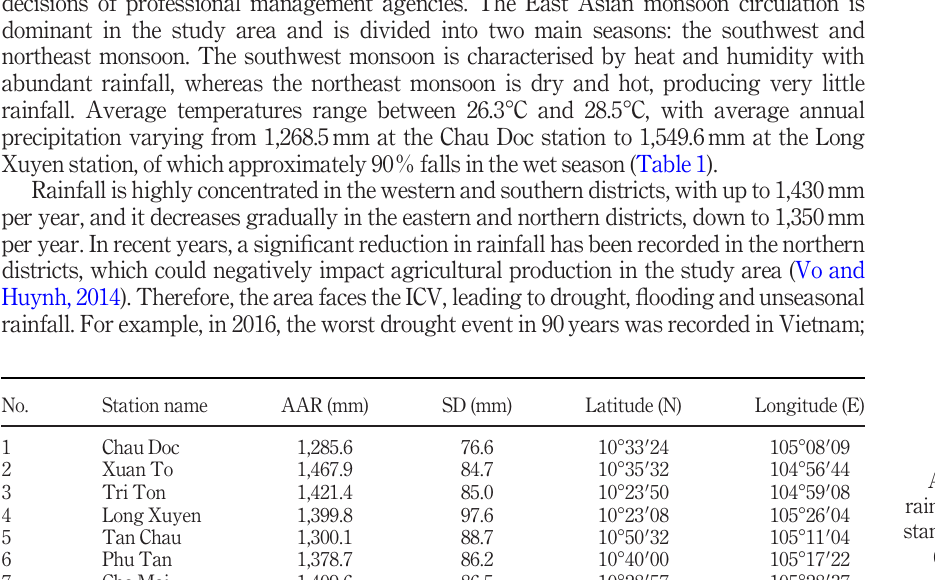
rainfall (AAR) and standard